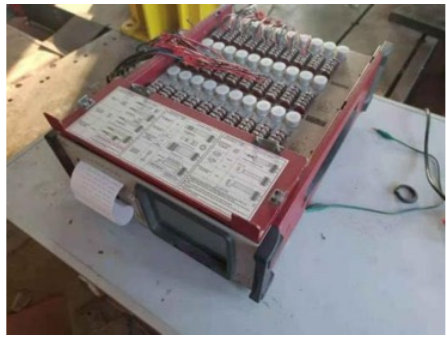
Figure 8. The test data acquisition equipment.